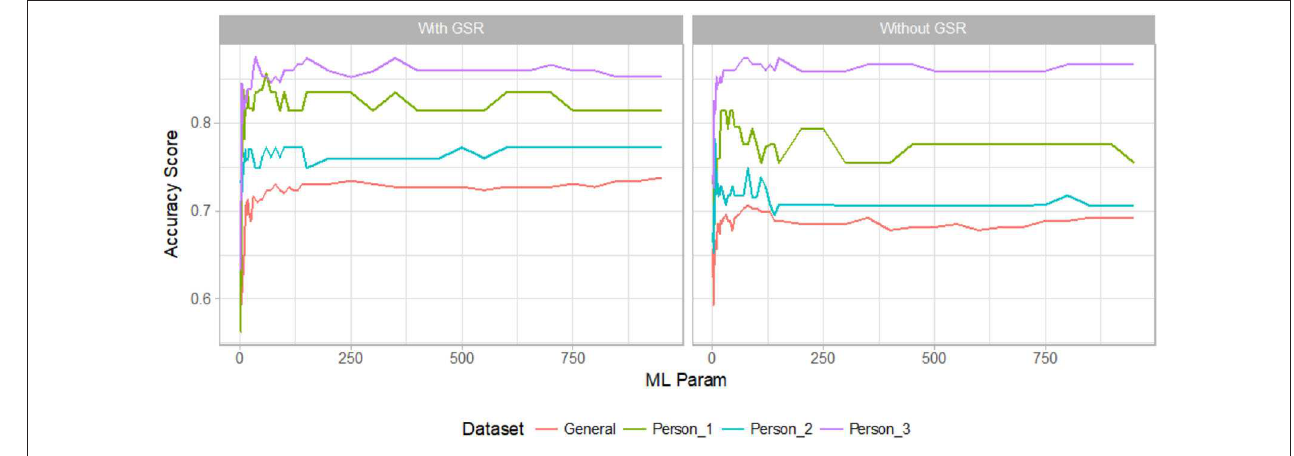
FIGURE 8 | Random forest classifier performance.